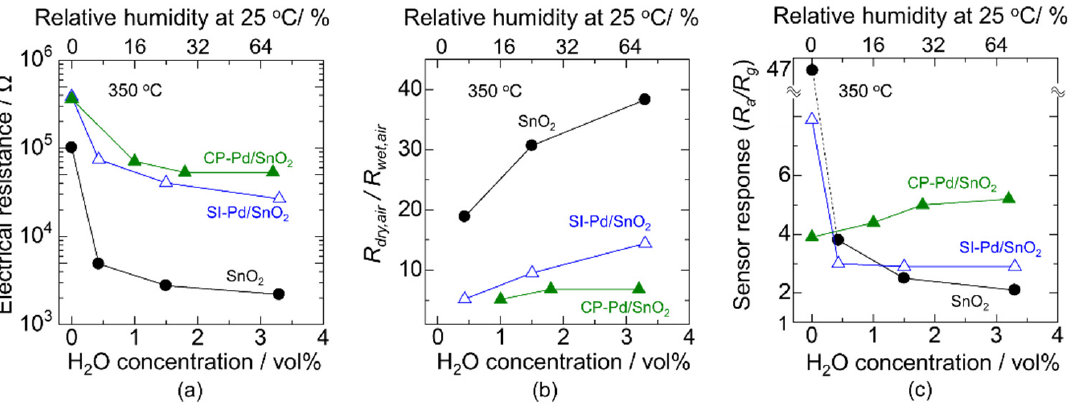
Figure 6. H 2 O concentration dependence of the ( a ) electrical resistance in air atmosphere, ( b ) ratio of the electrical resistance in dry air to that in wet air, and ( c ) sensor response to 200 ppm CO at 350 °C using bare-SnO 2 , SI-Pd/SnO 2 , and CP-Pd/SnO 2 .